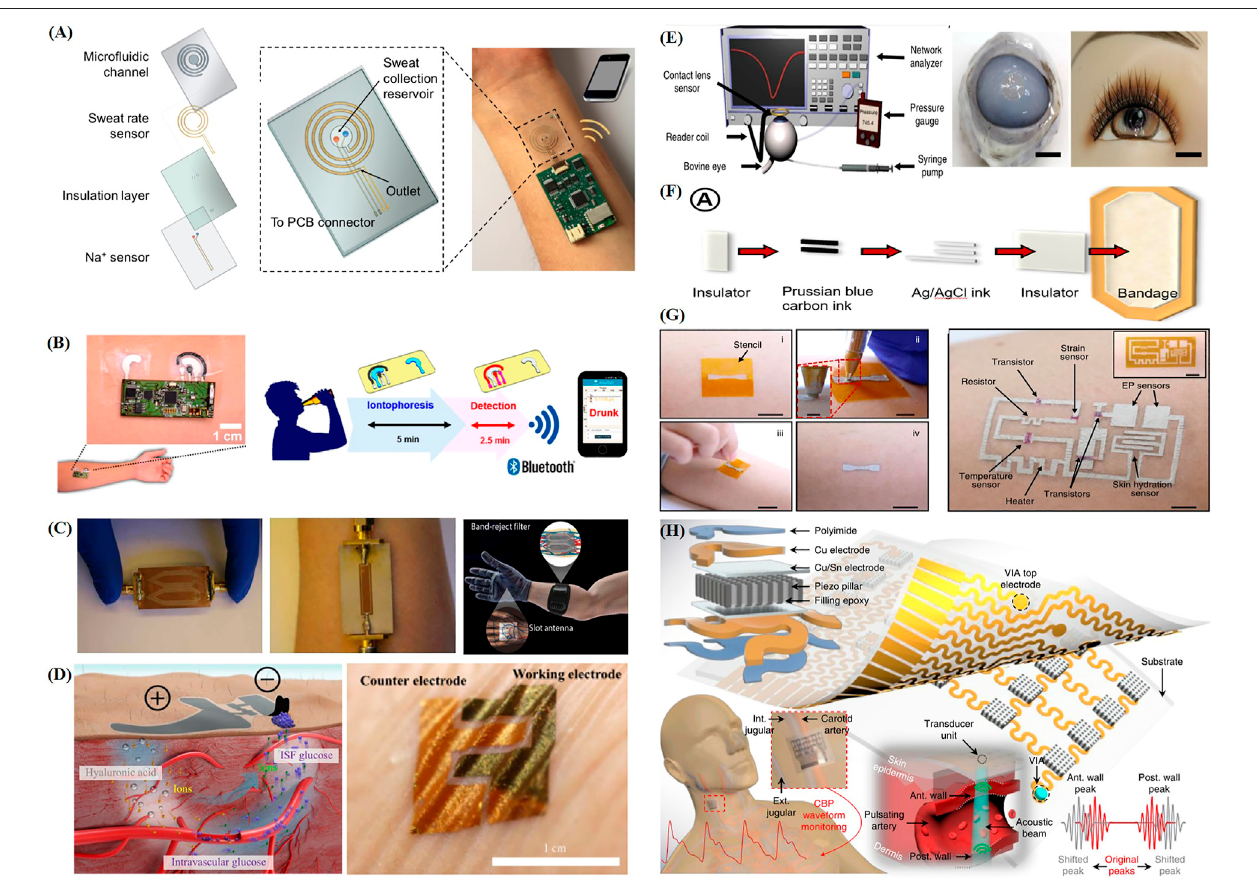
FIGURE2| Recentprogressofrepresentativeintelligentwearablesensorsdesignedforhealthmonitoring. (A) Schematicdiagramofthestructureandprincipleofa wearable sweat patch (Nyein et al., 2018). (B) Schematic illustration of the application of a skin tattoo-based wearable alcohol sensor patch to the skin and its wireless sensing principle (Kim et al., 2016). (C) Optical image of a wrist and back of hand based on an electromagnetic wave-sensing wearable device that imitates the vascular anatomy (Hanna et al., 2020). (D) Schematic diagram of a wearable skin biosensor system for non-invasive electrochemical monitoring of glucose in ISF (Chen et al., 2017). (E) Schematic of a contact lens sensing device used to monitor blood glucose and intraocular pressure and its appearance when fi tted (Kim et al., 2017c). (F) Schematicdiagramofscreenprintingbandagesensorpreparation(Kassaletal.,2015). (G) SchematicillustrationoftheDoScircuitpreparationprocessandstructure (Ershad et al., 2020). (H) Schematic diagram of the structure and operation principle of a wearable fl exible monitoring patch that uses ultrasound (Wang C. et al., 2018).